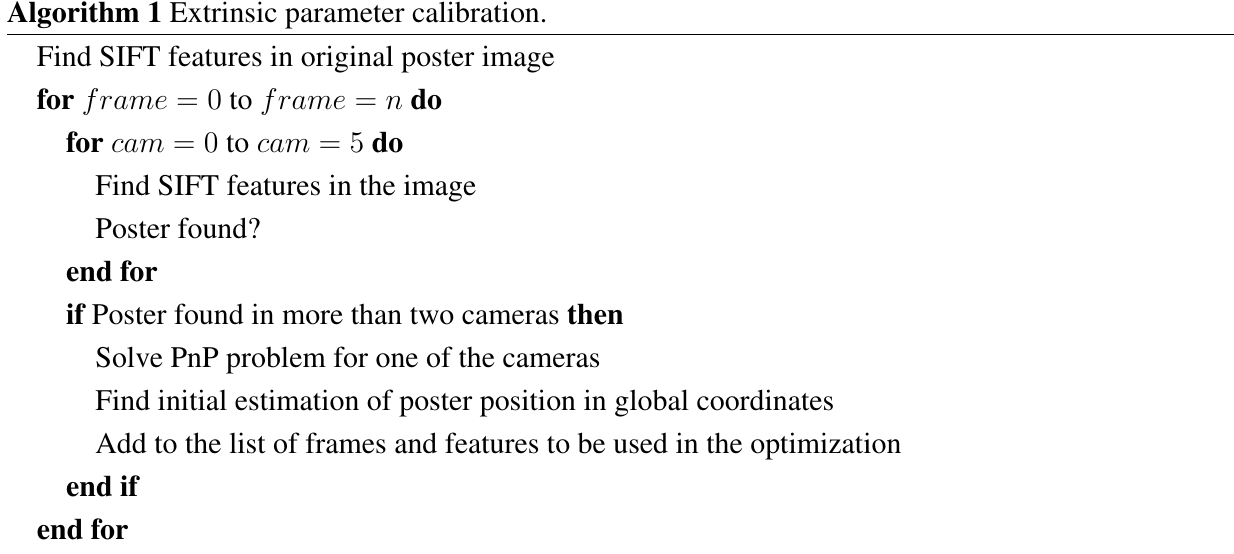
Algorithm 1 Extrinsic parameter